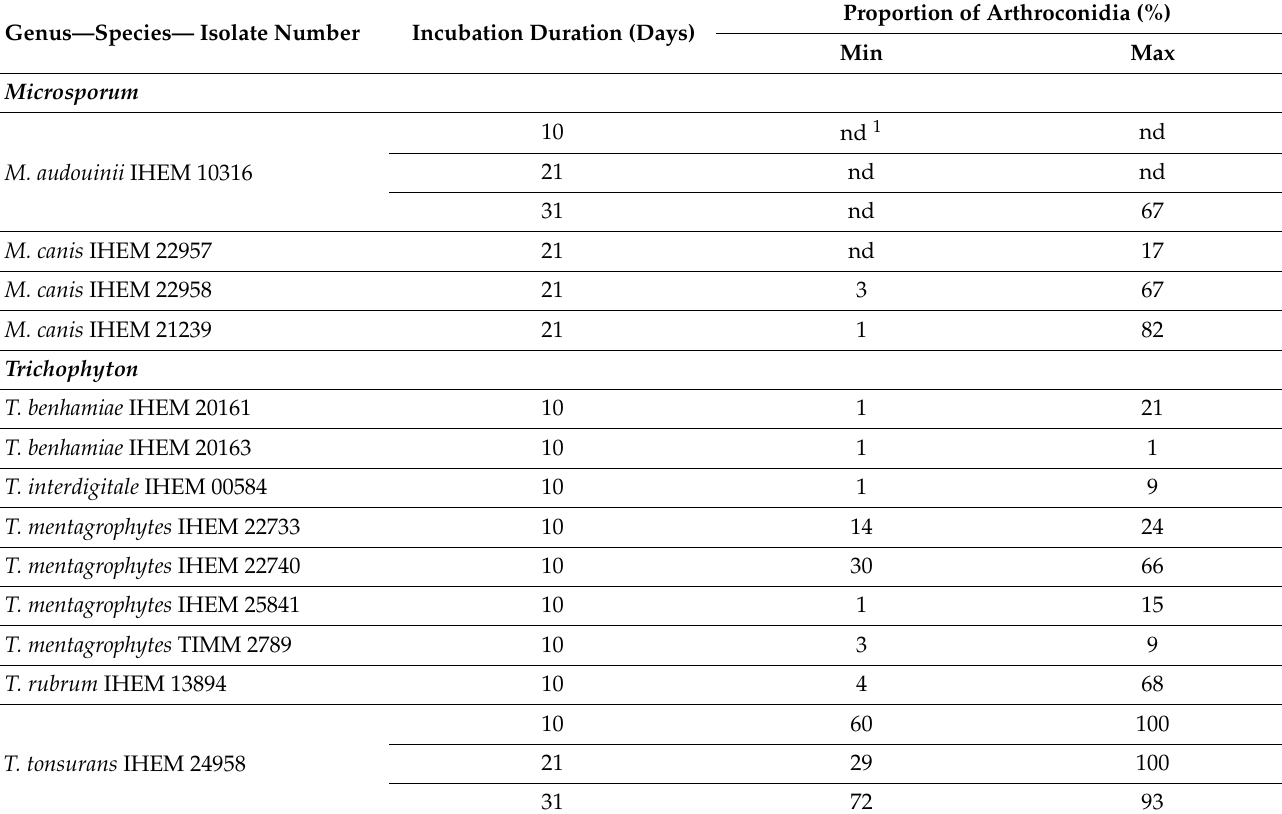
Table 4. Minimum and maximum proportions of arthroconidia produced after 10, 21 or 31 days of incubation on PDA at 30 ◦ C under 12% CO 2